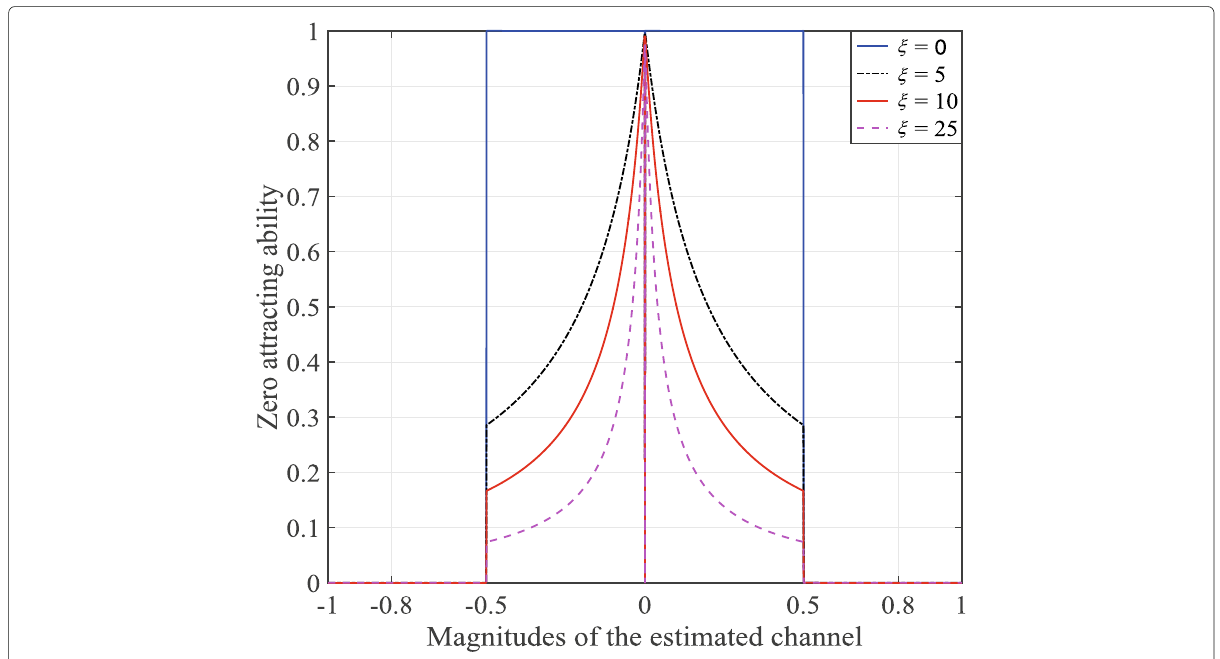
Fig. 3 The effects of ξ on the zero-attracting ability of the proposed ACC-PNMCC algorithm